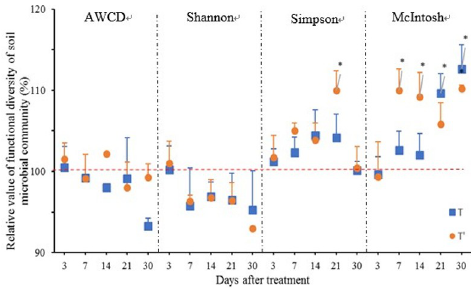
Fig 4. Variations in the soil microbial community index as affected by fluopyram. The dashed line shows the average percentage of control. The blue square represents the relative value of treatment on root development in the experimental field in May 2018; The orange circle represents the relative value of treatment on root development in the adjacent experimental field in August, 2018. “ � ” represents significant differences between treatment and control according to Tukey’s test (P <